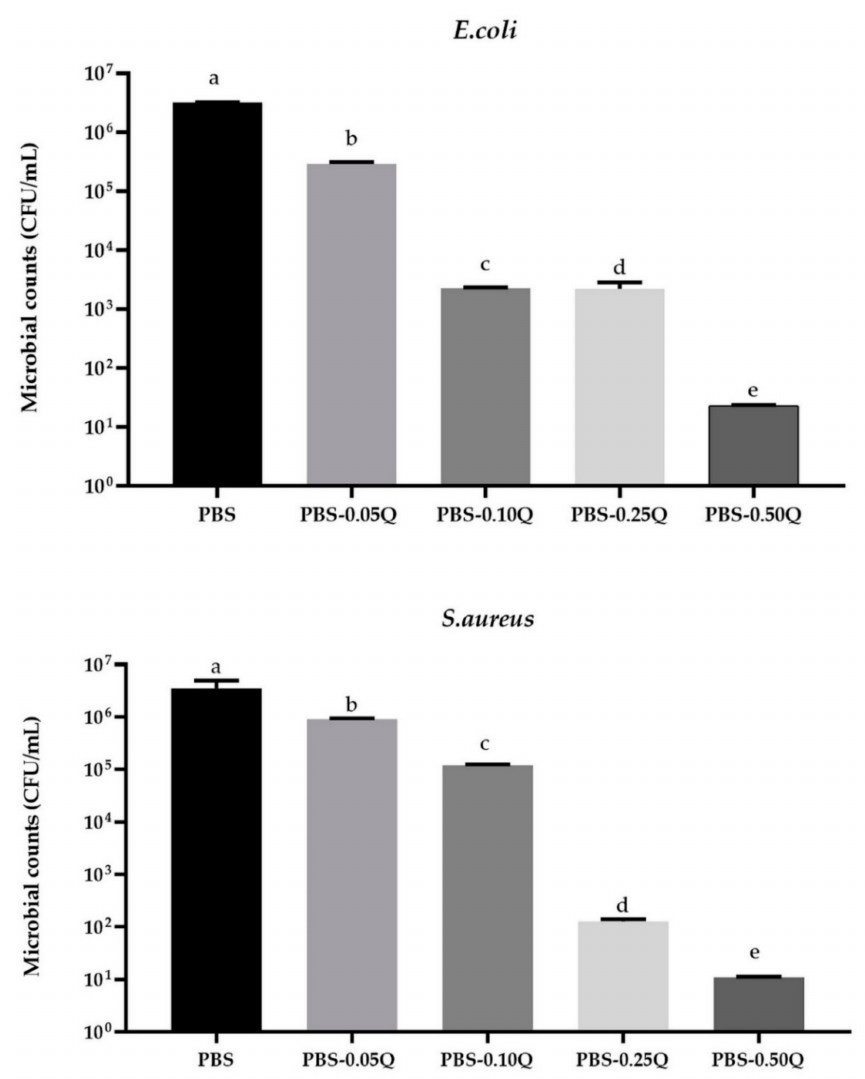
Figure 1. The effect of PBS-based neat and modified films on the viability of Escherichia coli and Staphylococcus aureus